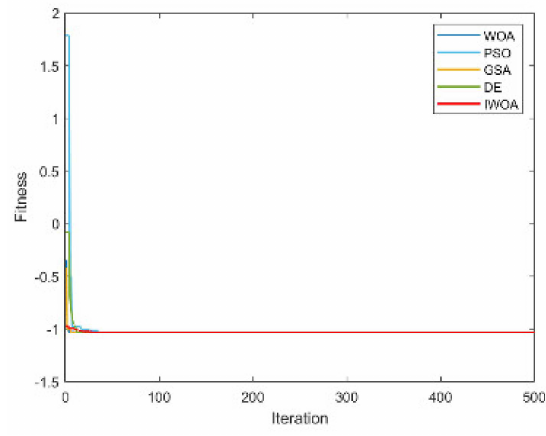
Figure A10. The convergence curve for solving F10.